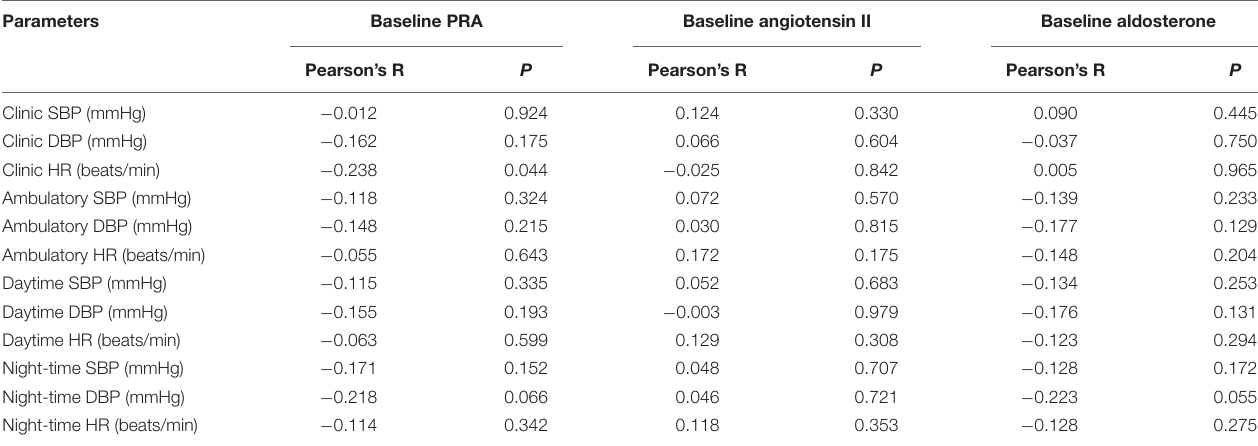
TABLE 3 | Correlations between baseline plasma renin activity (PRA), angiotensin II and aldosterone concentrations and changes in blood pressure and heart rate after 6 weeks of treatment with bisoprolol 2.5